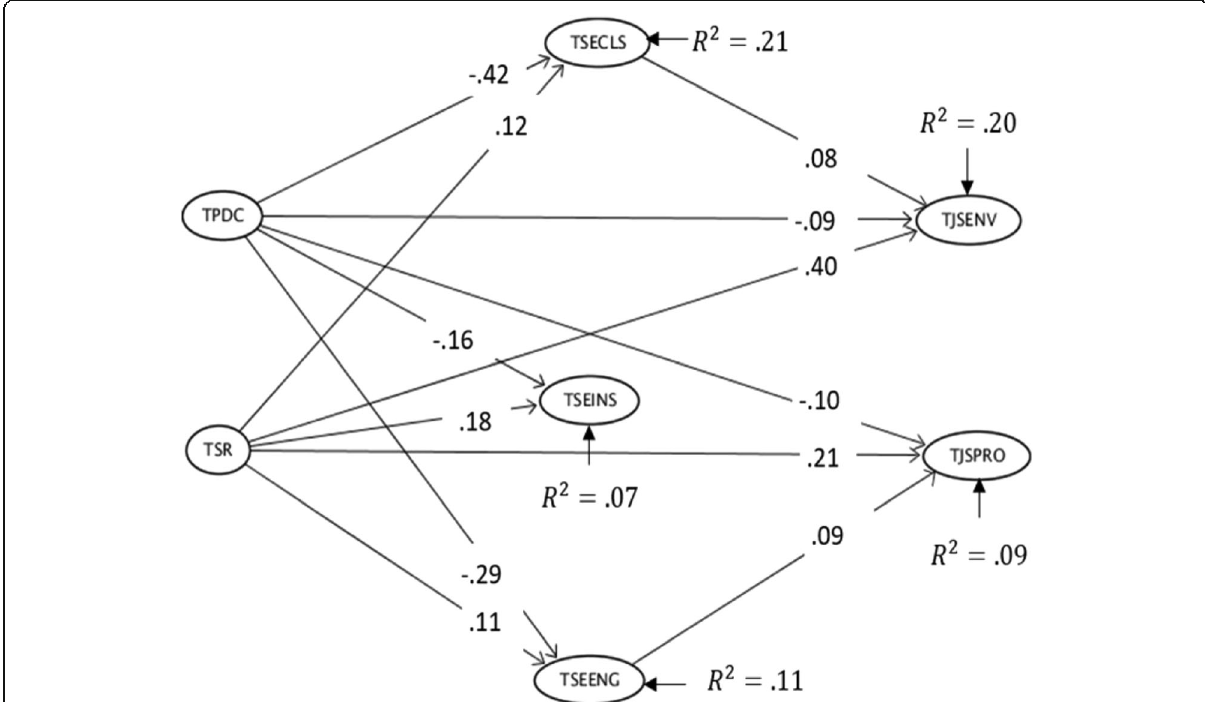
Fig. 2 A structural model of the effects of school climate (TPDC, teachers ’ perceived disciplinary climate and TSR, teacher-student relations) on job satisfaction (TJSENV, job satisfaction with work environment and TJSPRO, job satisfaction with profession) as mediated by the teacher self- efficacy (TSECLS, self-efficacy in classroom management; TSEINS, self-efficacy in instruction, and TSEENG, self-efficacy in student engagement). All parameter estimates are standardized and significant at p <